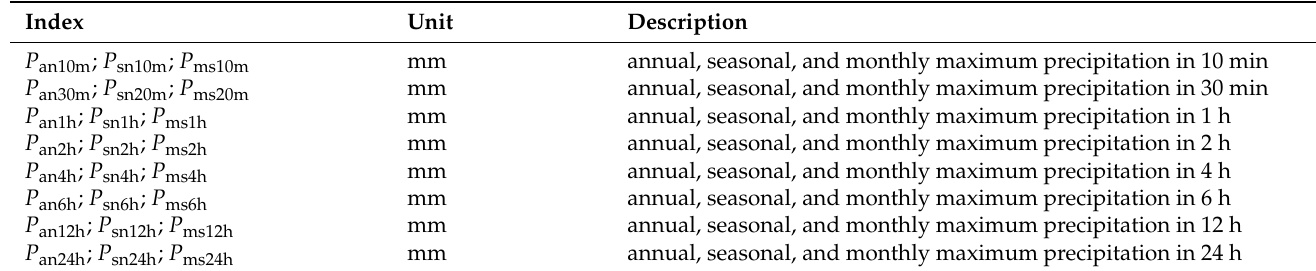
Table 1. Parameters associated with maximum rainfall